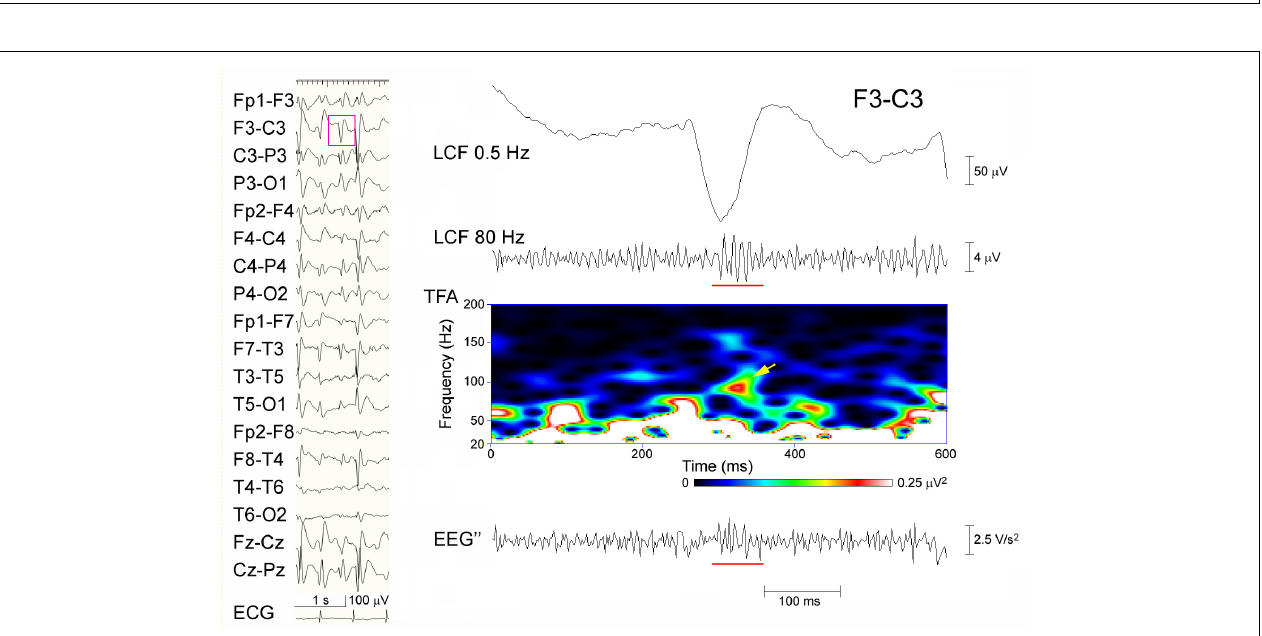
FIGURE 4 | A representative failure to detect ripples in Session B. Spike-waves are almost generalized in a sleep EEG that was recorded from an 8-year-old girl (left panel), and the EEG data (pink rectangle) at F3–C3 including the spike is temporally expanded and processed (right panel). From the top: filtered at 0.5 Hz; filtered at 80 Hz with ripple oscillations (underline) and background noise; TFA showing a clear spectral blob (arrow); and the EEG (cid:48)(cid:48) trace showing some spike-associated oscillations (underline) buried in noise-like background activity. In Session A, this spike was categorized as having ripples, whereas in Session B, neither of the reviewers judged it to include ripple